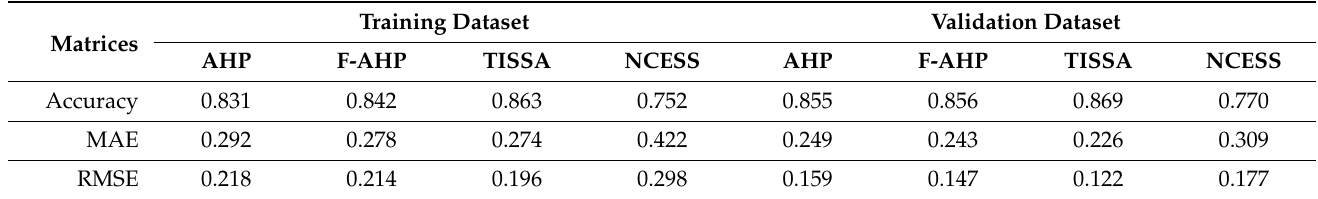
Table 12. Validation matrices and values of the training and validation